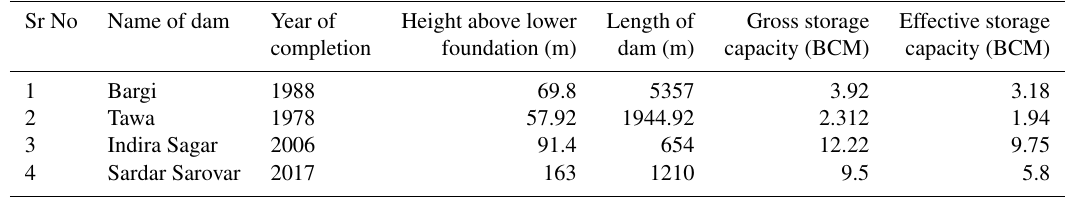
Table 1. Parameters of reservoirs that were considered in hydrological simulations.